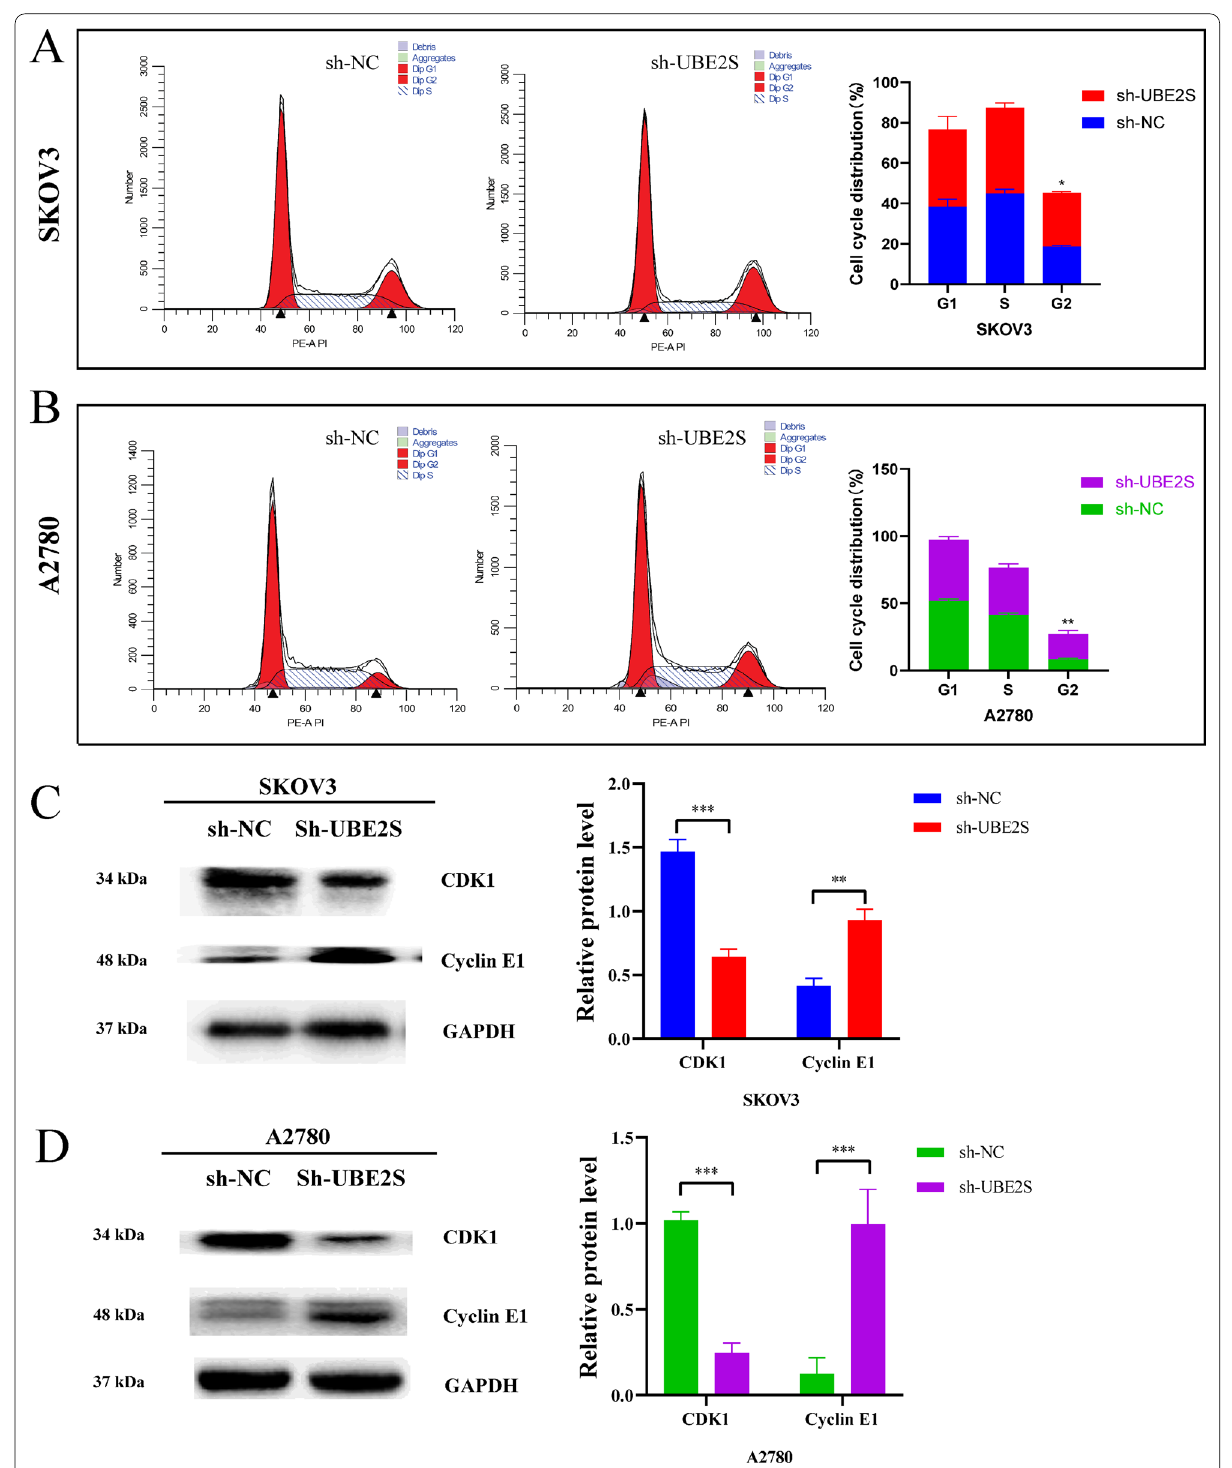
Fig. 10 The impact of UBE2S gene knockdown on cell cycle. A Cell cycle-related flow cytometry results and statistics of SKOV3 cells in sh-NC group and sh-UBE2S group. B Cell cycle-related flow cytometry results and statistics of A2780 cells in sh-NC group and sh-UBE2S group. C Western blot results and statistics of cell cycle-related proteins of SKOV3 cells. D Western blot results and statistics of cell cycle-related proteins of A2780